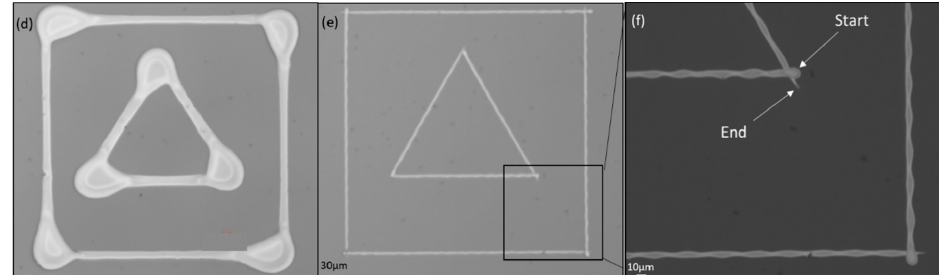
Figure 15 . 2D patterning with arbitrary printing directions (Supplementary Video, Ref. [10]). ( a ) Different printing directions for testing; ( b ) printing using the conventional constant jetting frequency method using jetting frequency of 10 Hz and low speed of 0.05 mm/s; ( c ) magnified printing result of ( b ); ( d ) printing at high frequency of 1750 Hz and target speed of 52.5 mm/s using the conventional constant frequency; ( e ) printing using the proposed equal spaced triggering of 30 μ m and printing speed of 52.5 mm/s, with dummy lengths of 3 mm; and ( f ) magnified printing result of ( e ).